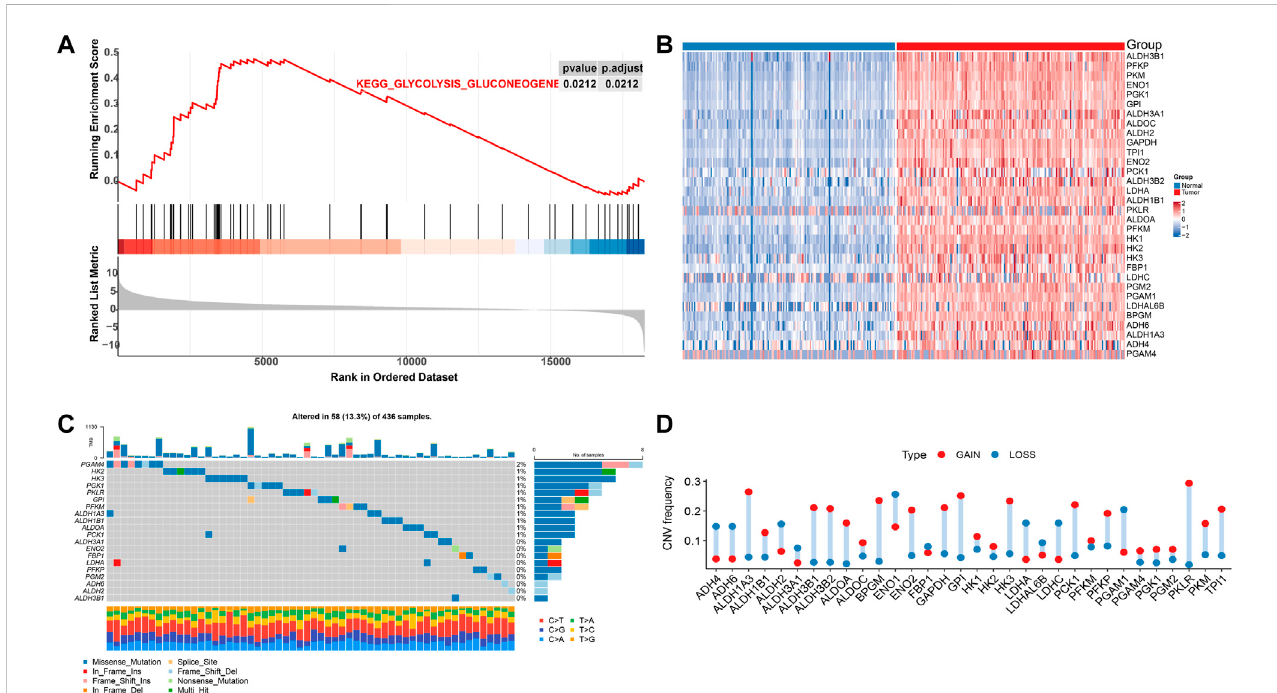
FIGURE 1 AnalysisofMMRGgenefunctionandcoregenemutationstatusinpancreaticcancer. (A) Disorderedmitochondrialenergymetabolism-relatedpathways in pancreatic cancer; (B) Heat map of core genes in signi fi cant gene concentration; (C) Mutation waterfall diagram of MMRG gene set; (D) CNV mutation frequency distribution